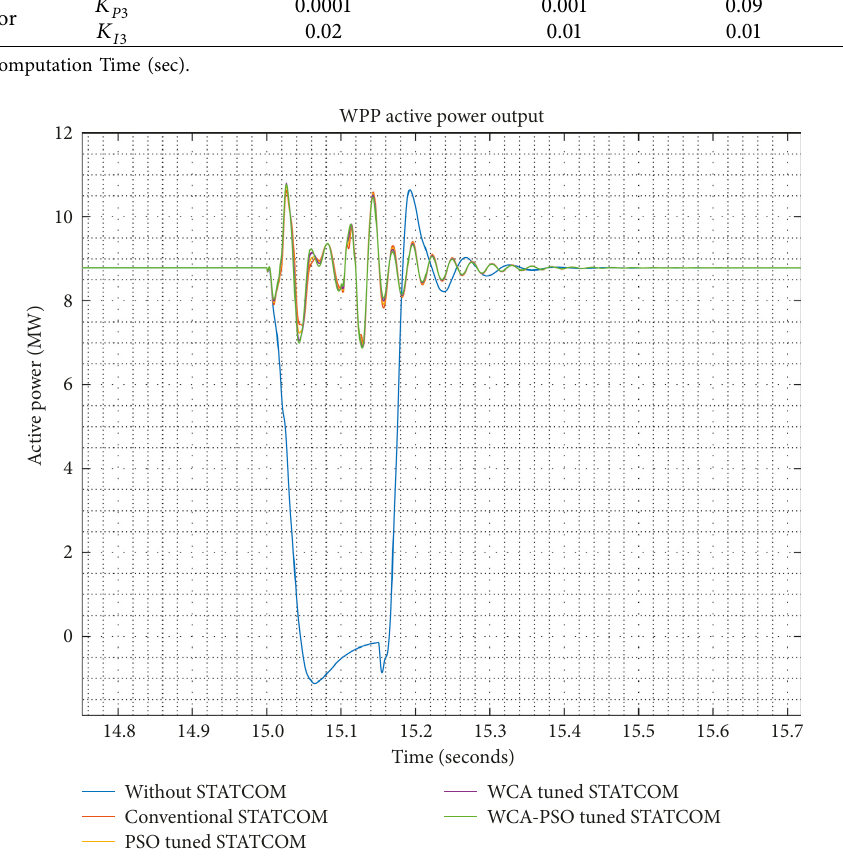
Figure 10: WPP active power output.